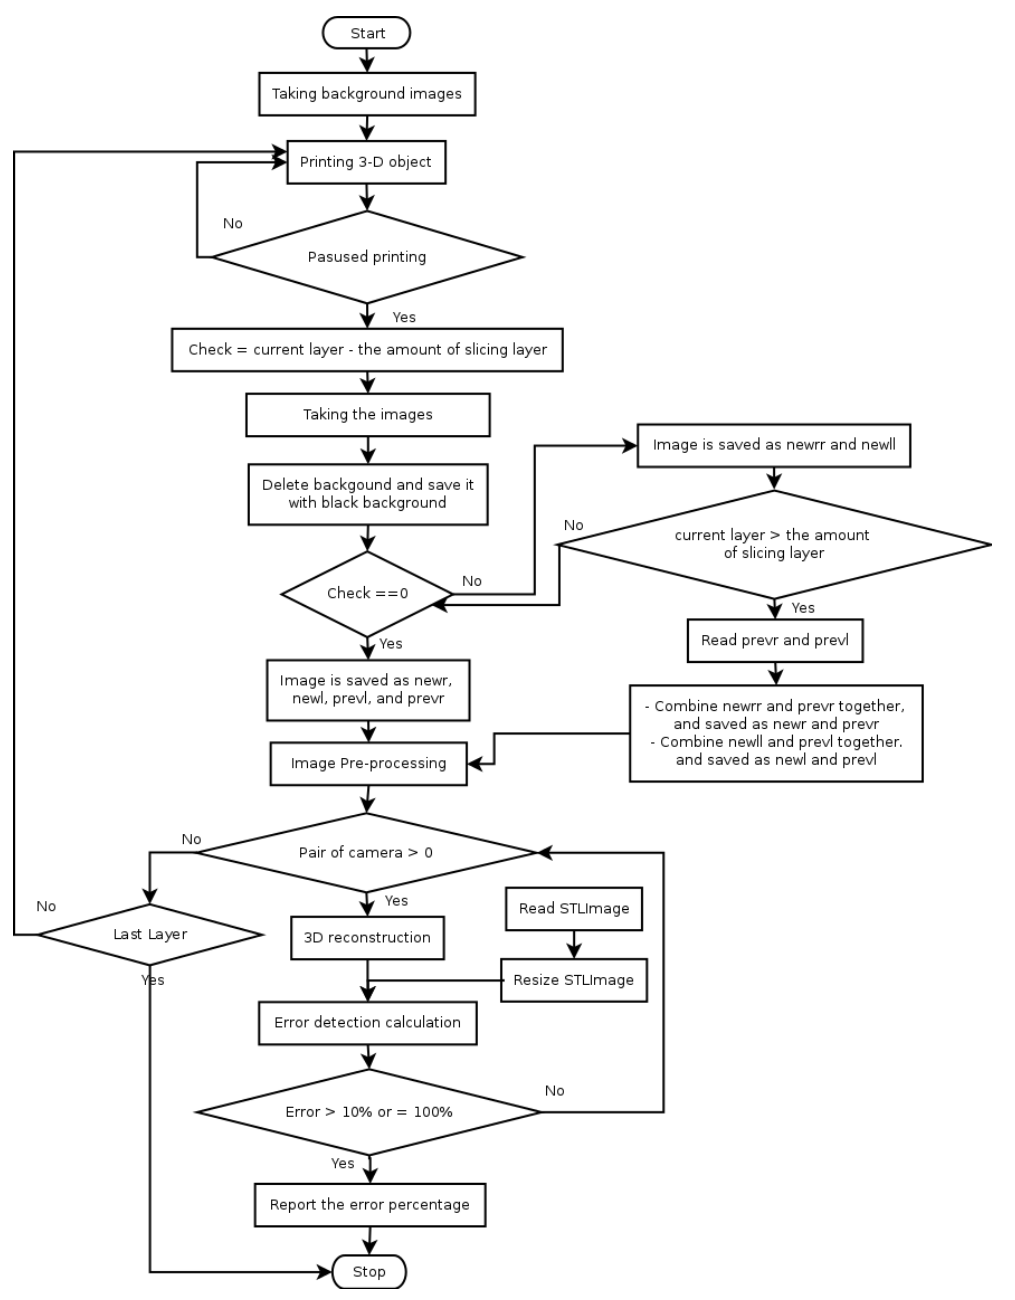
Figure 8. The double camera error detection system flowchart.